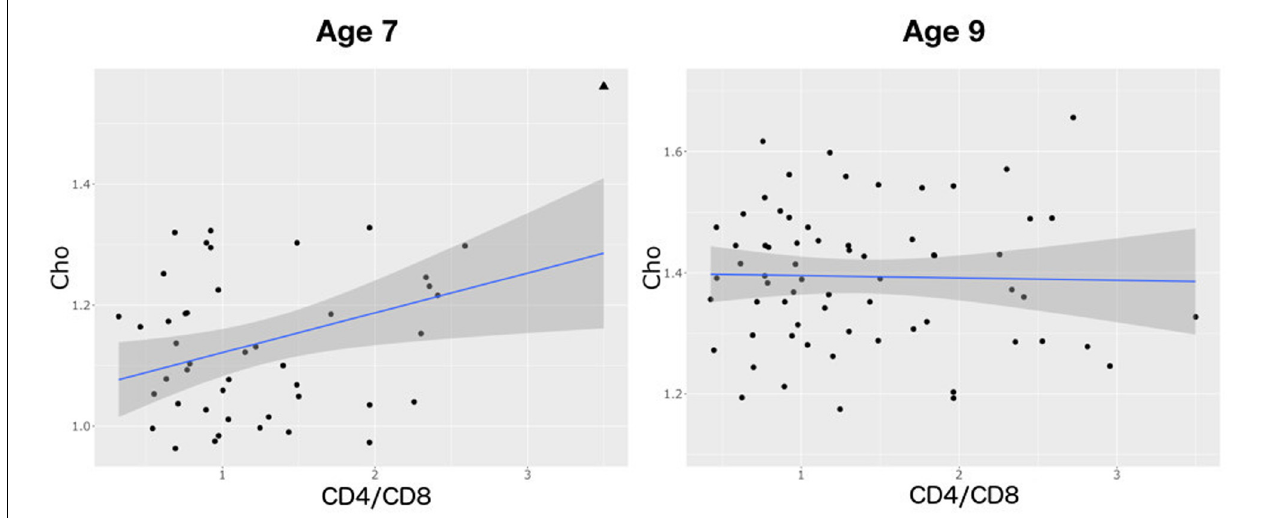
FIGURE 3 | Plots showing a positive relationship between choline and CD4/CD8 ratio at age 7 ( B = 0.0521, SE = 0.02, p = 0.01) and none at age 9 ( B = 0.0026, SE = 0.07, p = 1.0). Triangle denotes an influential outlier excluded from statistical